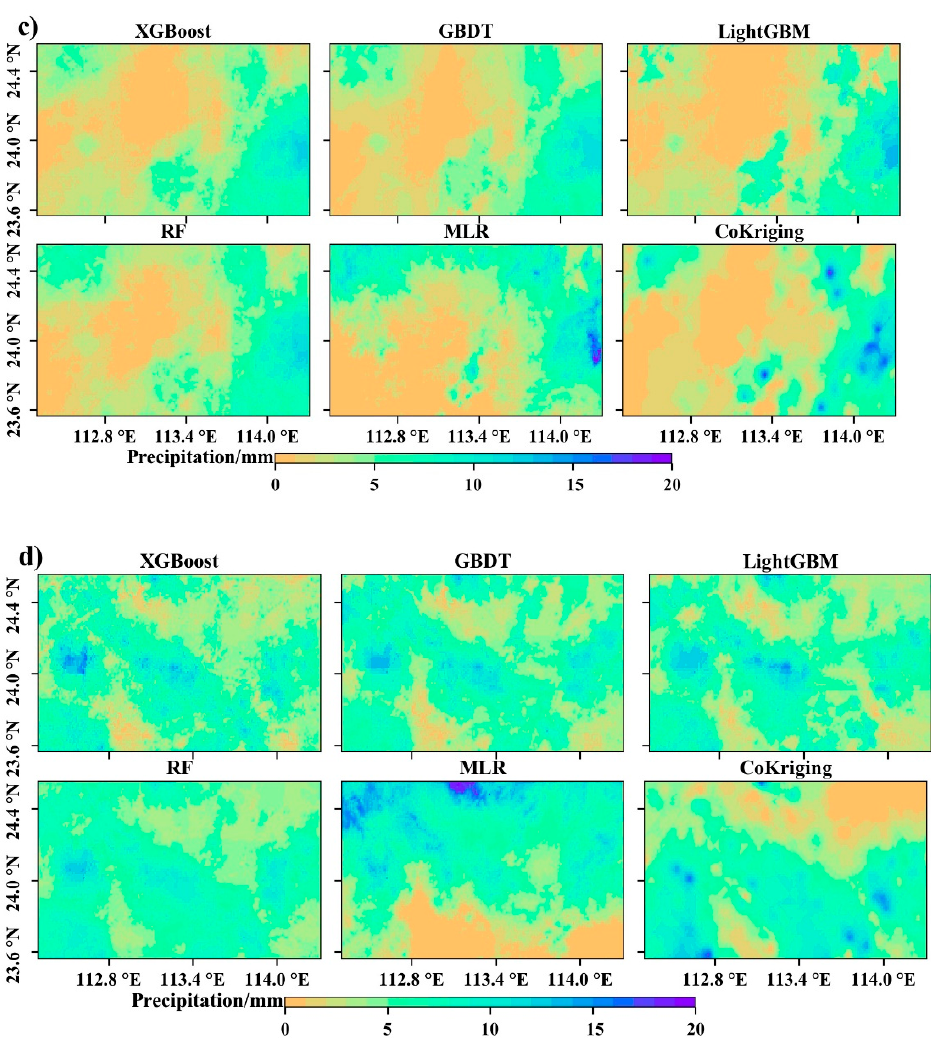
Remote Sens. 2022 , 14 , x FOR PEER REVIEW 18 of 25